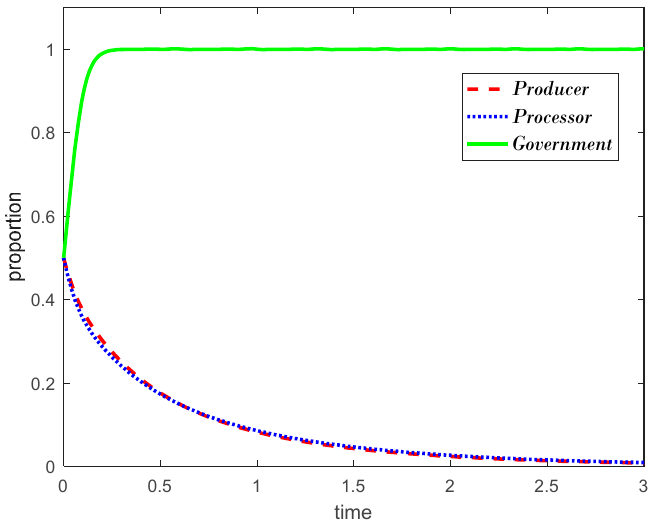
Figure 3. The evolutionary path of case 1.